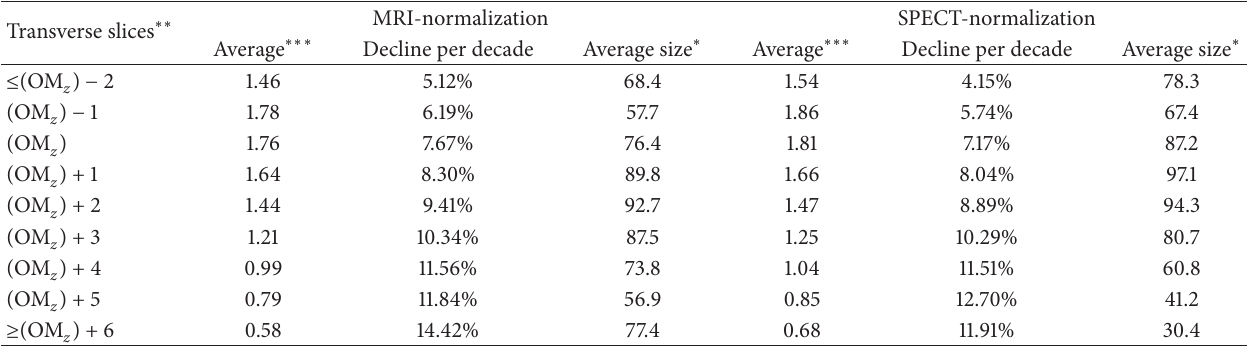
Figure 2: Boxplots of the three groups: 18–30, 31–45, and 46–61 years old, in the 18 methods of determining striatal DAT availability. The high decline of DAT availability per decade determined by SPECT-delineation method (9.47%) was partly caused by outliners. There were six outliners (arrowheads) in the SPECT-delineation method. Instead of a two-sided normal distribution of the outliners, all the six outliners were less than the mean. It might thereby lead to a high decline of DAT availability per decade. Table 3: Striatal DAT availabilities, declines per decade of DAT availabilities, and striatum sizes in the transverse slices of the striatum ROIs defined by the atlas